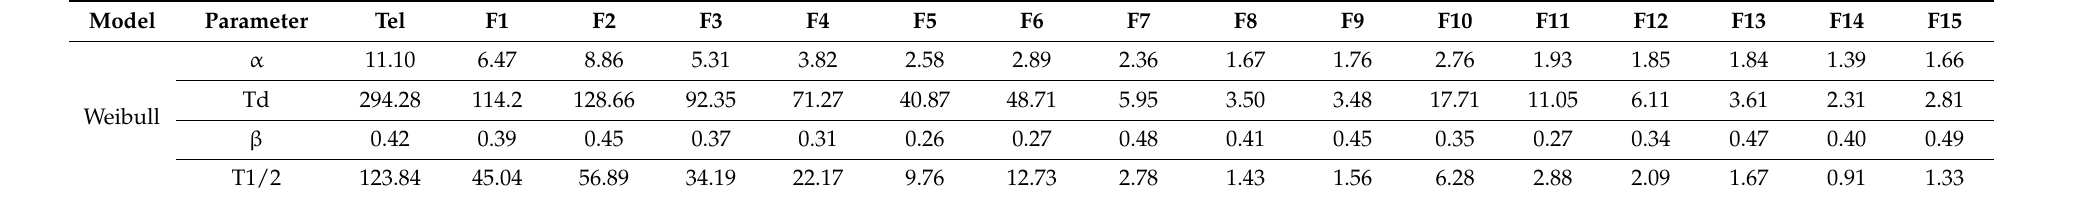
Table 4. Weibull models